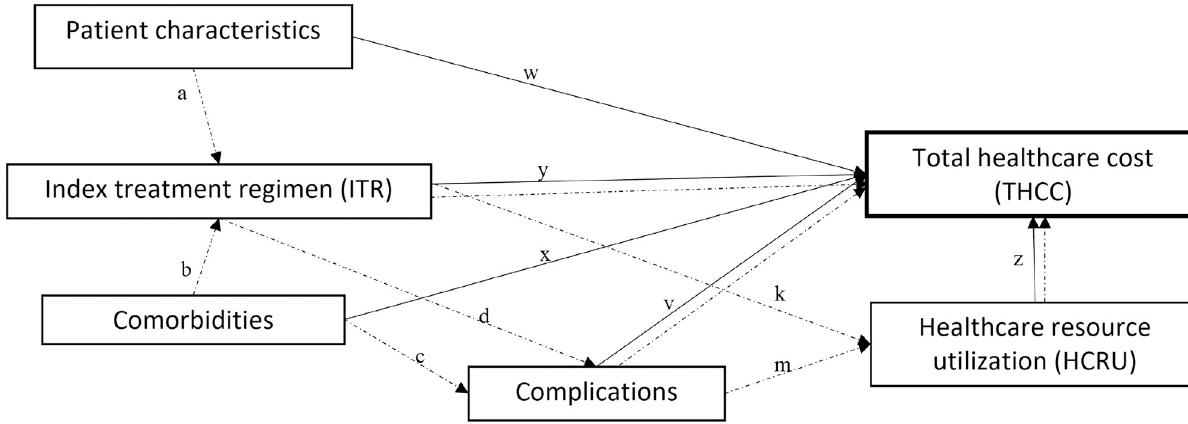
Fig 2. SEM pathway diagram used for each cohort. Solid lines indicate relationship specified as direct effect on THCC in the model and dotted lines indicate relationship specified as indirect effect on THCC via mediator(s) in the model.